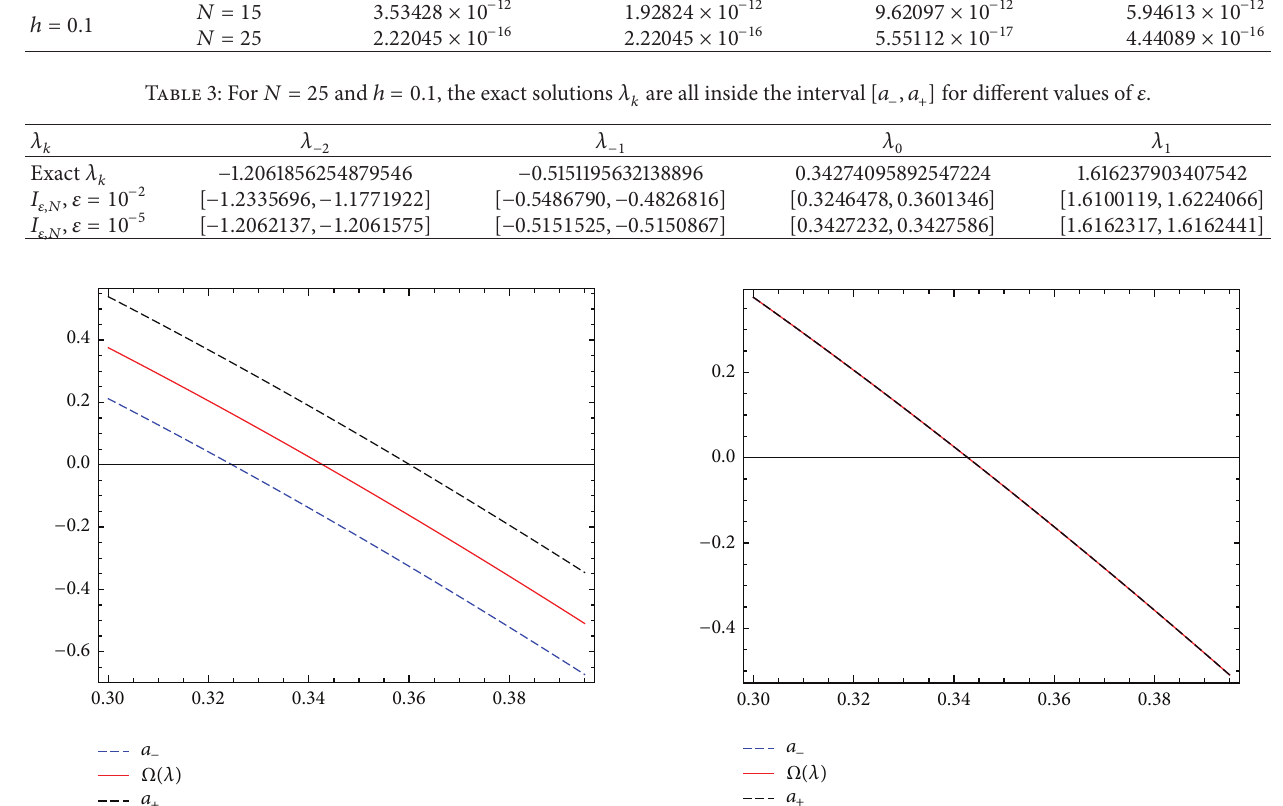
Figure 2: The enclosure interval dominating 𝜆 0 for ℎ = 0.1 , 𝑁 = 25 , and 𝜀 = 10 −5